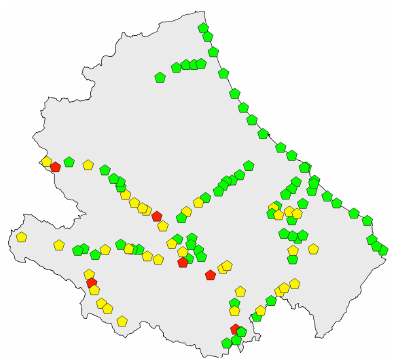
Figure 12. The railway stations of Abruzzo and their expected level of exposure to the landslide hazard.